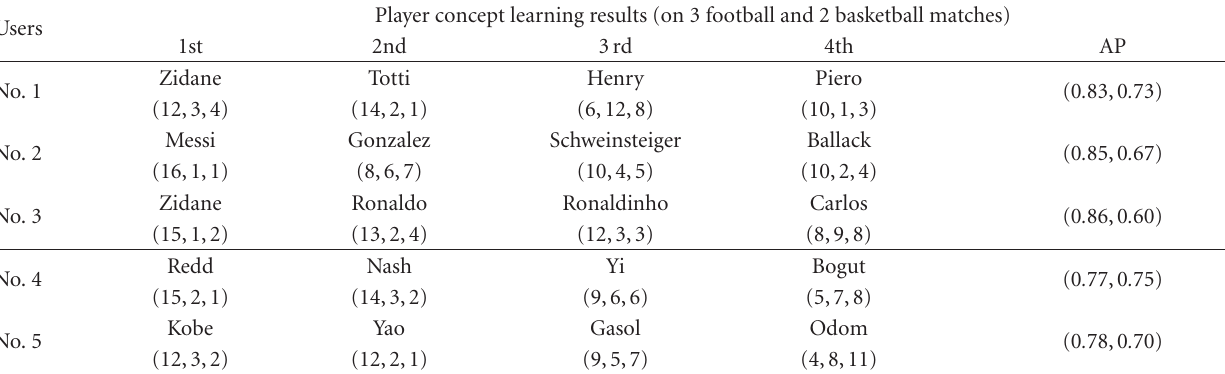
Table 7: Learned user preference on player